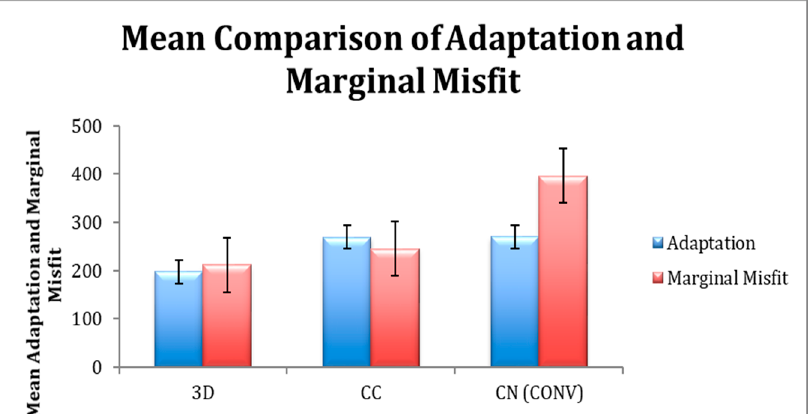
Figure 3. Comparison of marginal integrity and adaptation for three fabrication techniques. Table 3. Mean and standard deviation of surface roughness.